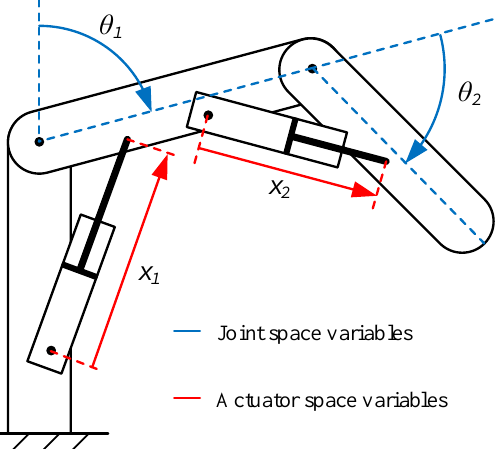
Figure 2. Joint space coordinates and actuator space coordinates shown for a two degree of freedom crane.